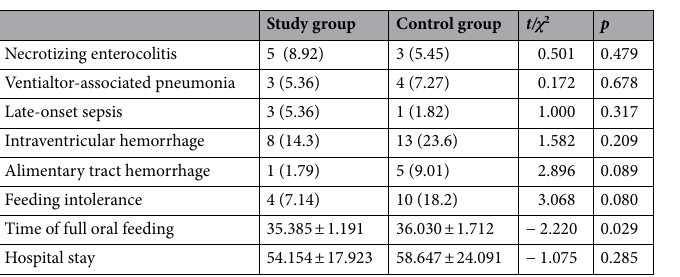
54.154 ± 17.923 58.647 ± 24.091 − 1.075 Table 4. Clinical outcomes between two groups at the time of discharge.